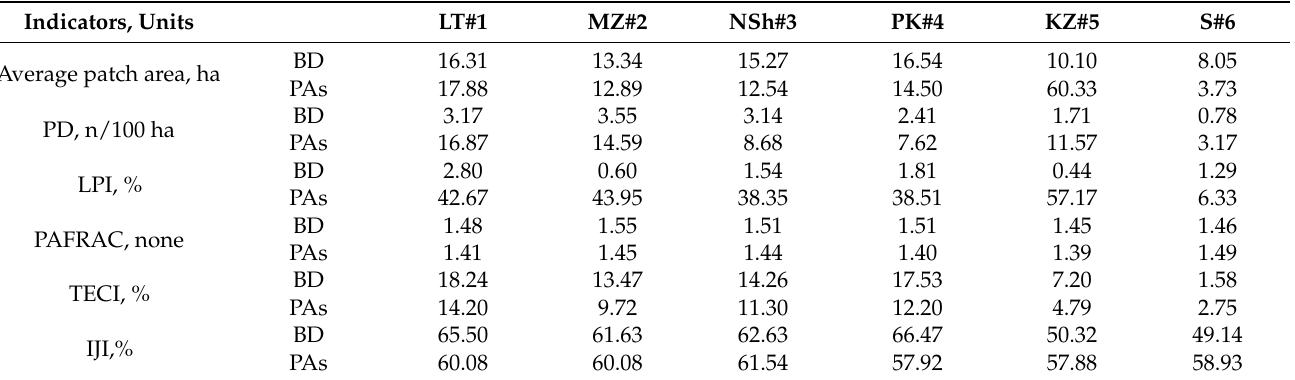
Table 4. Forest fragmentation metrics in PAs and in BDs.